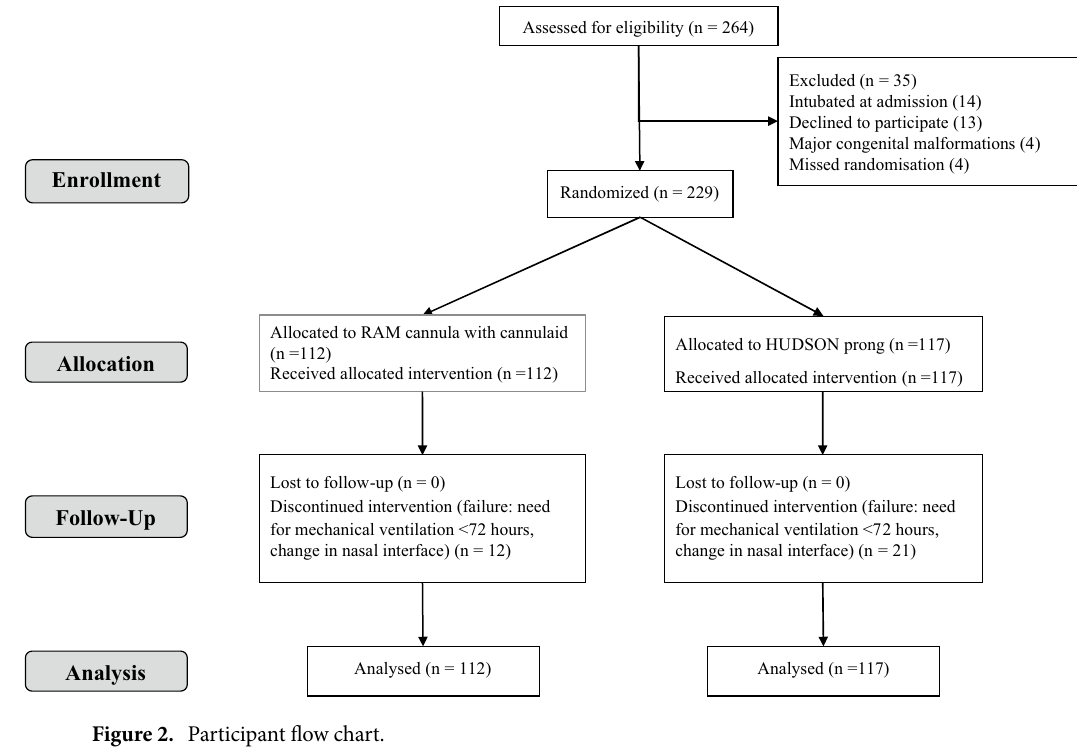
Figure 2. Participant flow